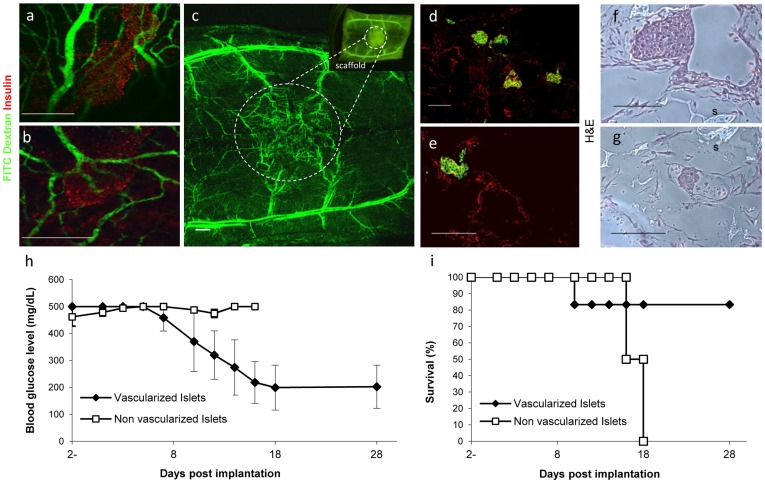

In vivo biofunctioning of 3D vascularized islet constructs.5-day old vascularized or non-vascularized 3D islet constructs were implanted into the peritoneal subcutaneous area of streptozotocin-induced diabetic mice. (a, b) 3D pre-vascularized constructs were removed 2 weeks after implantation, sectioned and immunostained for insulin (green) and vWF (red) to identify human ECs. Scale bar-200 µm. (c, d) Histological examination of H&E-stained, implanted vascularized islet constructs, retrieved 1 week following restoration of blood glucose levels (200 mg/dl) in each animal. S = scaffold. Scale bar-200 µm. (e, f) Vascularized islet implants were retrieved from mice 14 days post-implantation and following injection of FITC-dextran to the tail vein. Samples were then immunofluorescently stained with anti-insulin antibodies (red) and viewed with a laser scanning confocal stereomicroscope (Leica). Scale bar-100 µm. (g) Functional, FITC-dextran-perfused vessels in the engineered vascularized islet implant, viewed with a laser scanning confocal stereomicroscope on day 14 post-implantation. Scale bar-200 µm. (h) Blood glucose levels and (i) Survival of streptozotocin-induced diabetic mice after implantation of vascularized or non-vascularized islet-bearing scaffolds (50 islets per scaffold) implanted after a 5-day culturing period (vascularized implant, n = 6, non- vascularized, n = 4).